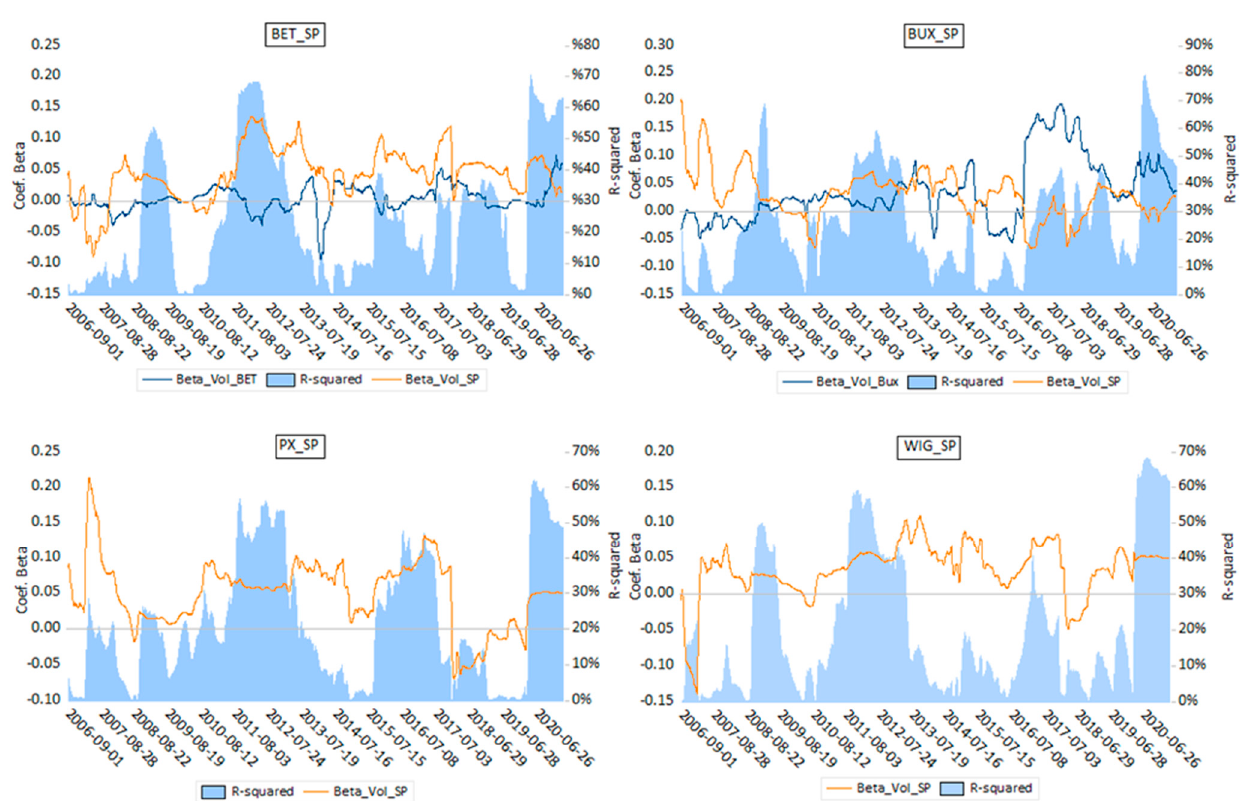
Figure A6. The Relationship between the Conditional Correlation Coefficients and the Conditional Volatilities—Rolling Stepwise Regression (Correlation with the S&P500 Index).